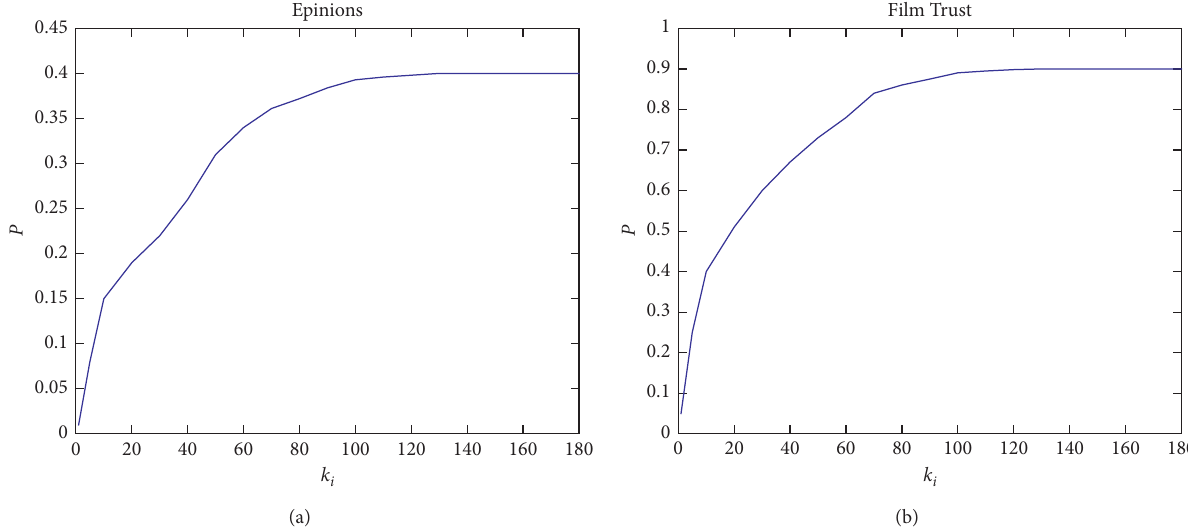
Figure 9: The optimal p value as a function of item degree k